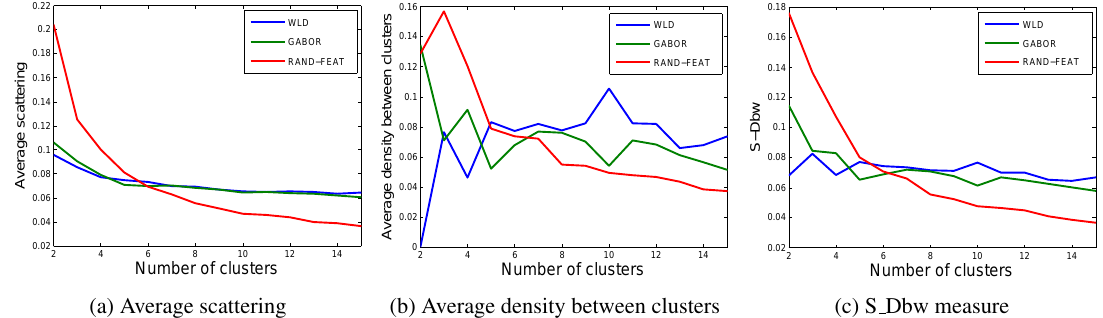
Figure 3: Internal evaluation of clusters for three kinds of feature descriptors (e.g., WLD, Gabor, Rand Feat) and different number of clusters.